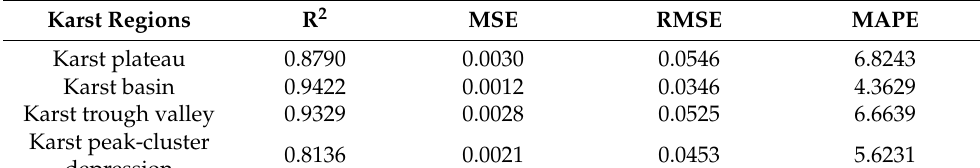
Table 3. The prediction accuracy of the RF model.